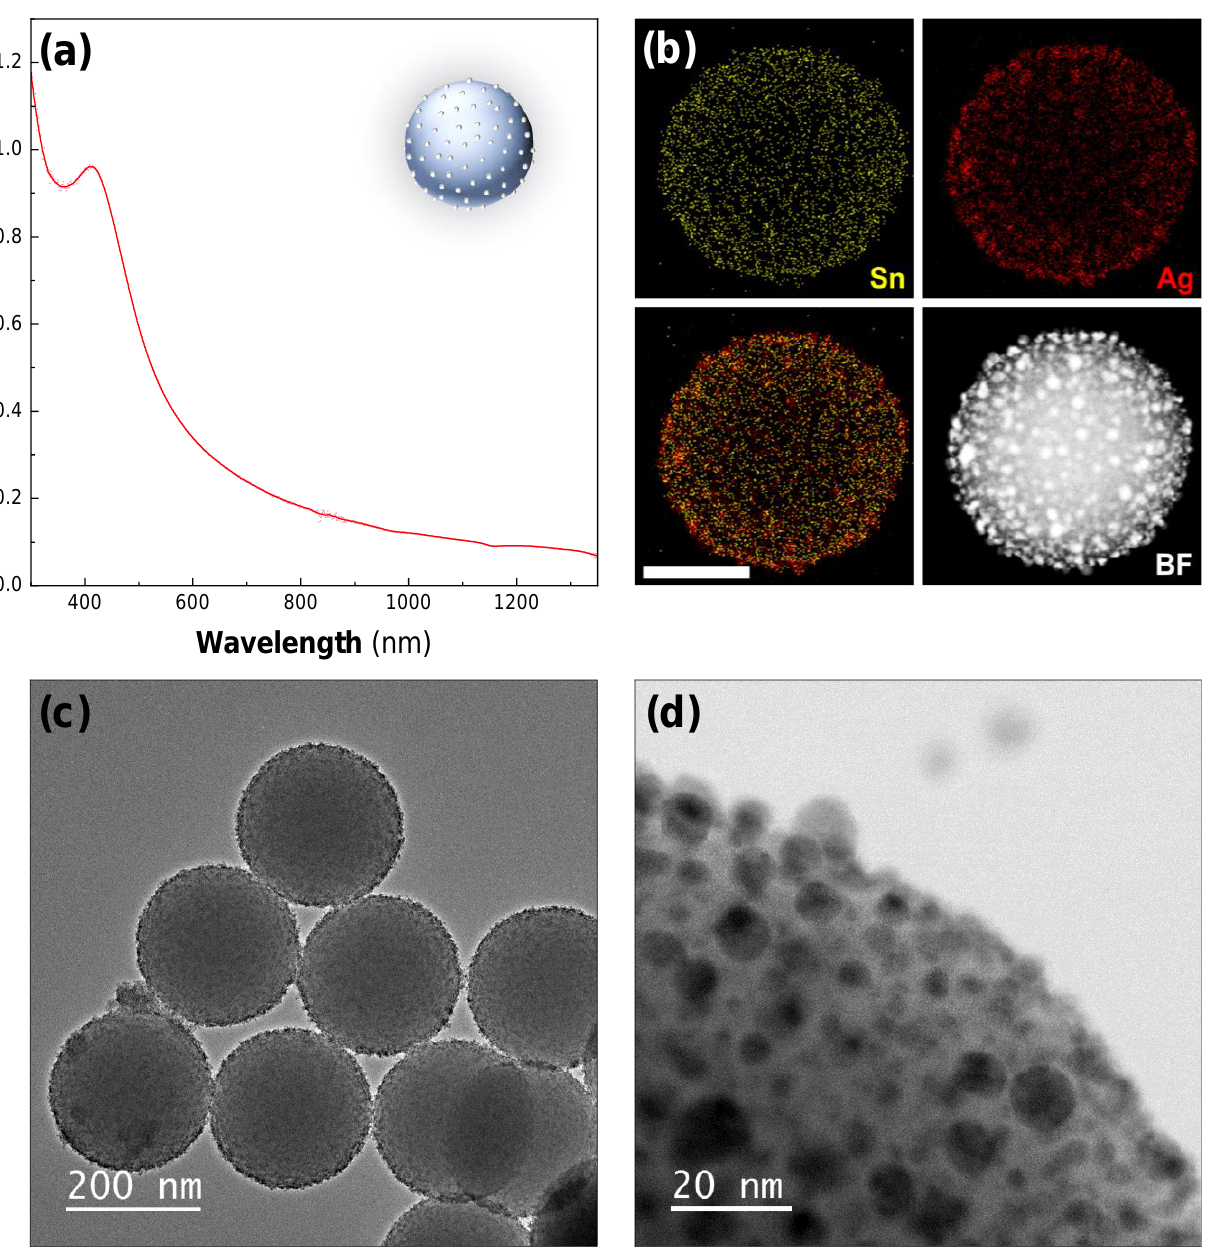
Figure 1. The Ag seeds deposited on silica particles. ( a ) UV – Vis – NIR spectrum — Ag seeds deposited on 200-nanometer silica particles. ( b ) The STEM – EDX elemental analysis revealing tin (yellow, top-left), silver (red, top-right), and an overlaid view (bottom-left) and corresponding high-angle-annular-dark-field (HAADF) STEM image (bottom-right). The scale bar represents 100 nm. The TEM images of the sample at ( c ) low and ( d ) high magnification are also shown.